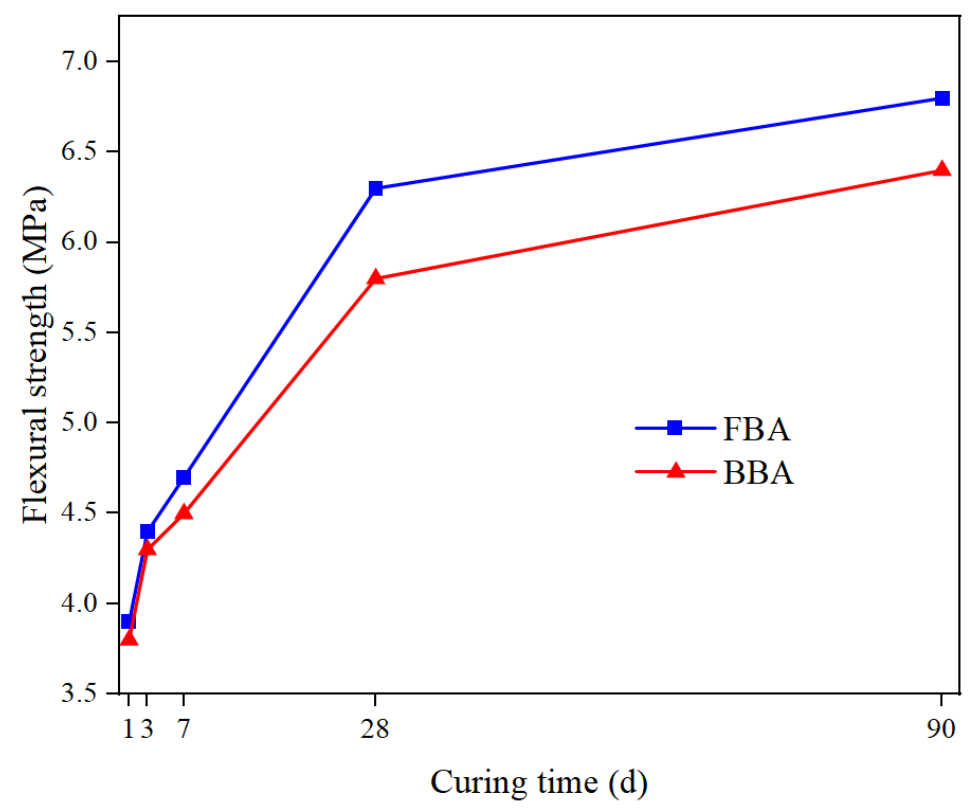
Figure 7. The effect of BA type on the flexural strength of MPC mortar (group 20 BA-80 MPC). The effect of FBA content on the compressive strength of MPC mortars at different curing ages is shown in Figure 8. The effect of BA type on the compressive strength of MPC mortar (group 20 BA-80 MPC) is presented in Figure 9. By comparing Figures 7 and 8, the